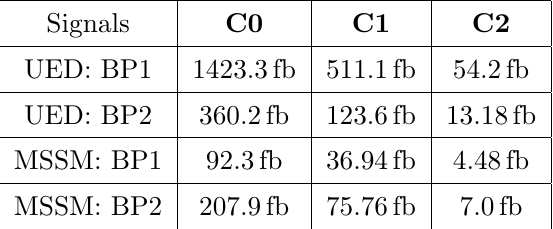
Table 4 . Cross-sections for the MUED and MSSM benchmarks at 13 TeV after subsequent imple- mentation of the cuts as mentioned in the